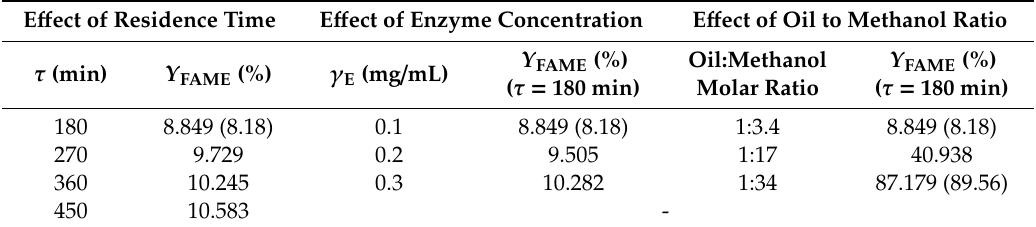
Table 3. Optimisation of the process by model simulation (values in brackets are results obtained from laboratory